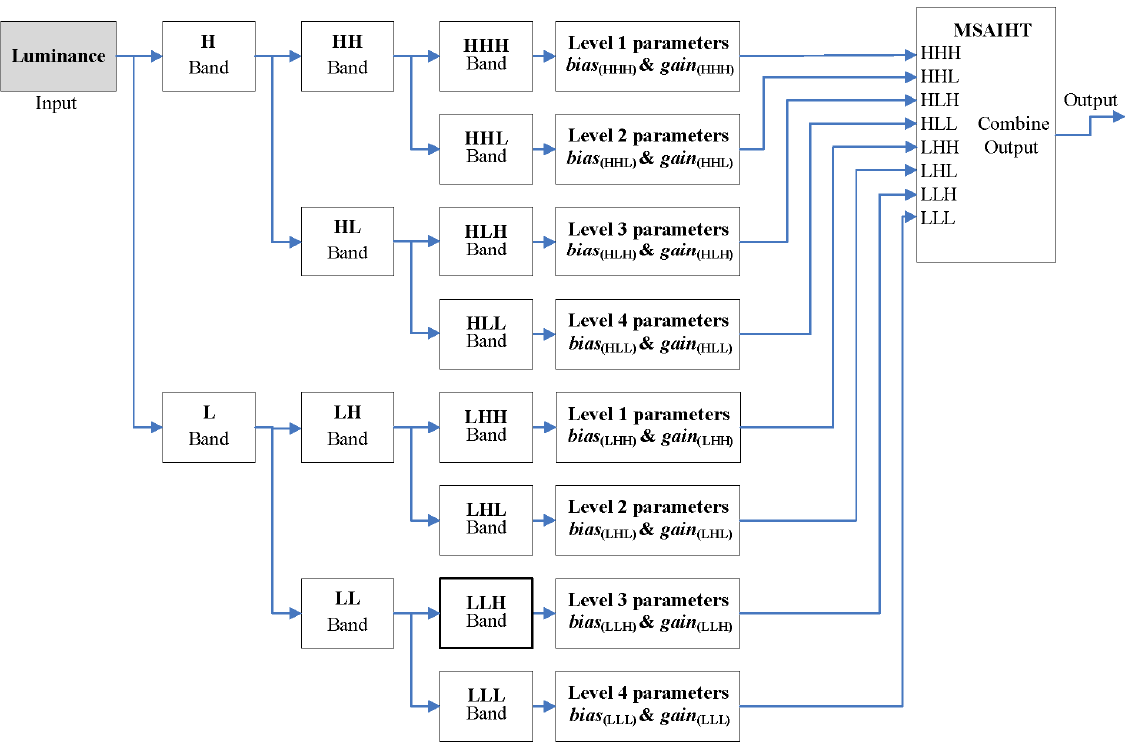
Figure 2. A block diagram of 8SAIHT parameter